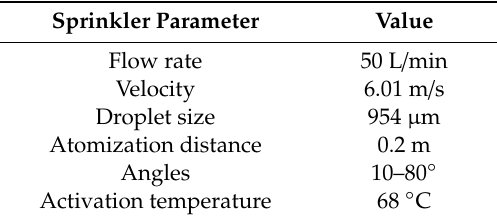
Table 1. Sprinkler parameters and estimated sprinkler spray parameters.